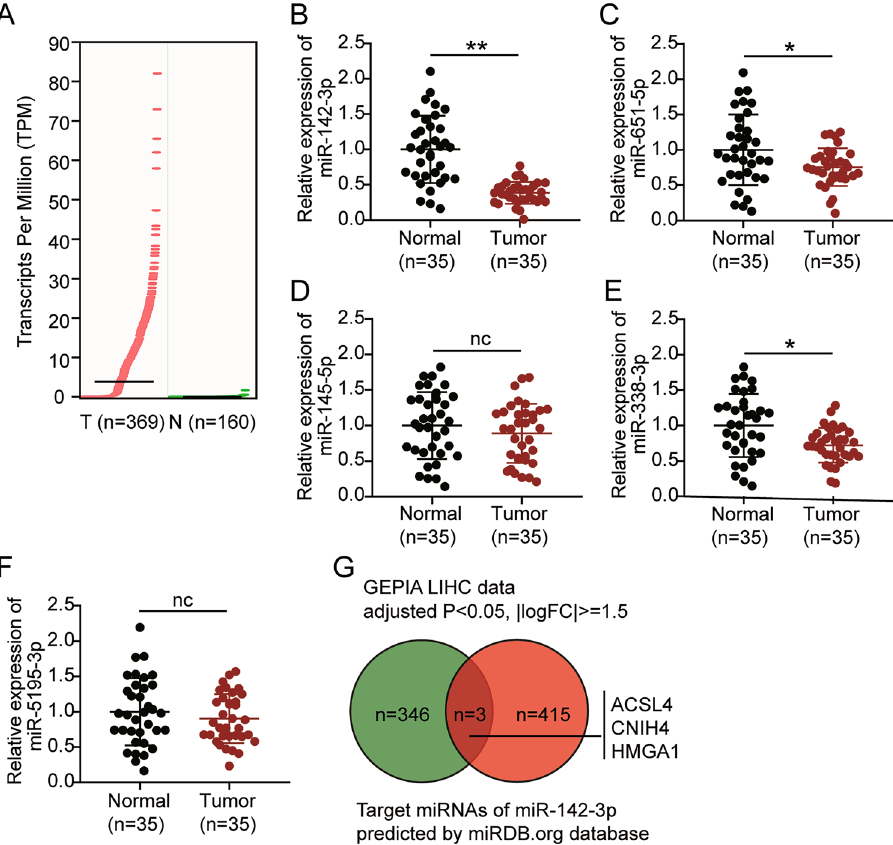
Figure 1. The expression of miR-142-3p and HMGA1 was aberrant in LIHC. ( A ) The expression of ST8SIA6-AS1 in LIHC tissues and normal hepatocellular tissues. Data from GEPIA database. ( B – F ) The expression of miR-142-3p ( B ), miR-651-5p ( C ), miR-145-5p ( D ), miR-338-3p ( E ), miR-5195-3p ( F ) in LIHC and normal liver tissues. *P < 0.05, **P < 0.001. nc: not significant. ( G ) The intersection of miRDB-predicted targets of miR-142-3p as well as the DE (differentially expressed) genes from GEPIA LIHC data (logFC ≥ 1.5 and adjusted P < 0.05,). LIHC: hepatocellular